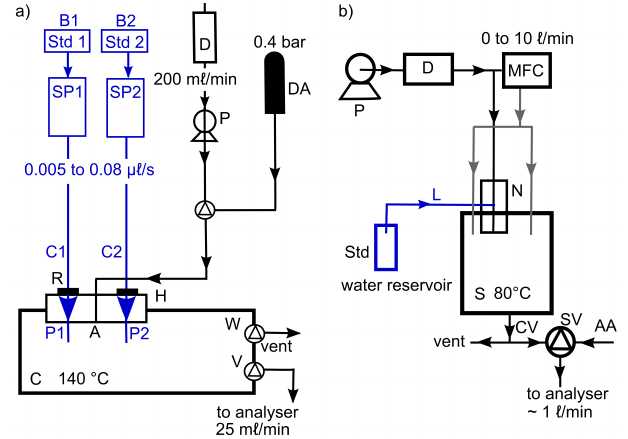
Fig. 1. Flow diagram of the calibration units. (a) Standard